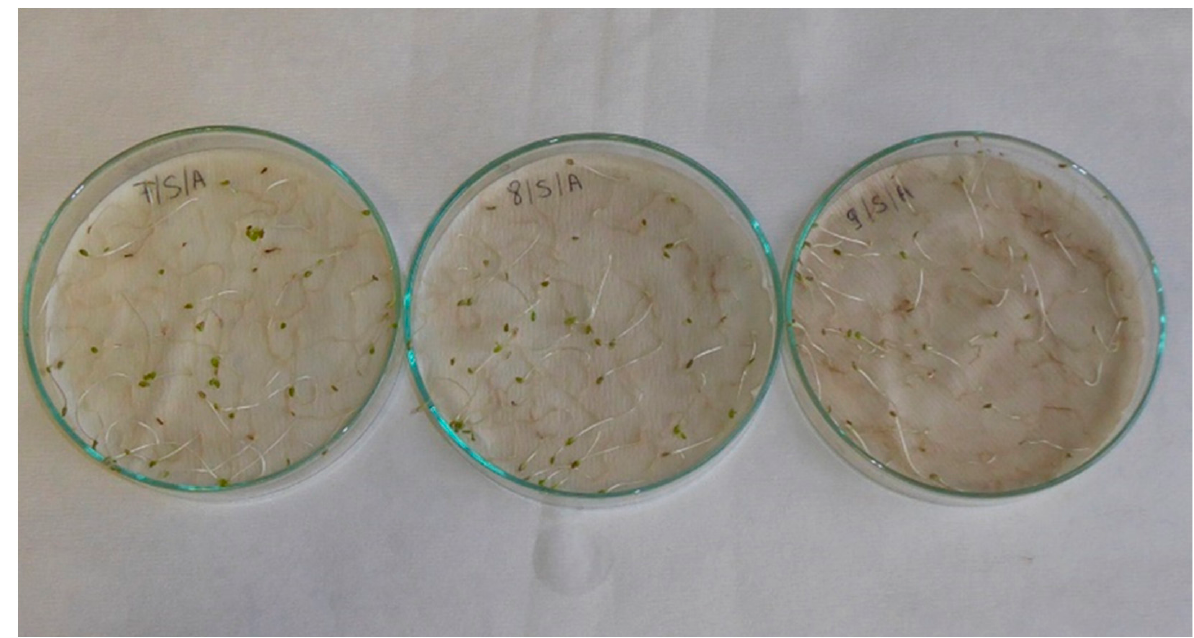
Figure A9. Lettuce ( Lactuca sativa L.) seedlings; treatments with aqueous extracts of chia ( Salvia hispanica L.) in 2.5% concentration ( left ) 5% concentration ( middle ) and 10% concentration ( right ).